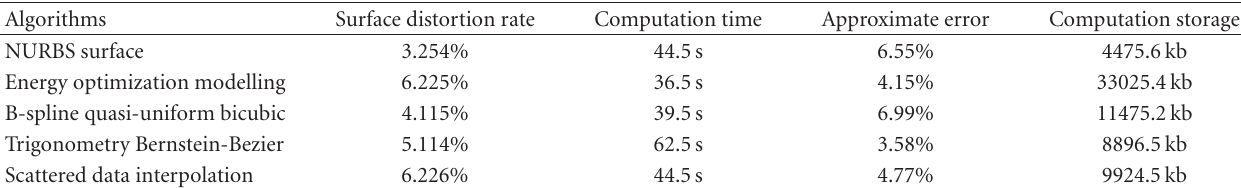
Table 13: Performance comparison of di ff erent surface fitting algorithms during the modeling processes of turbulence kinetic energy